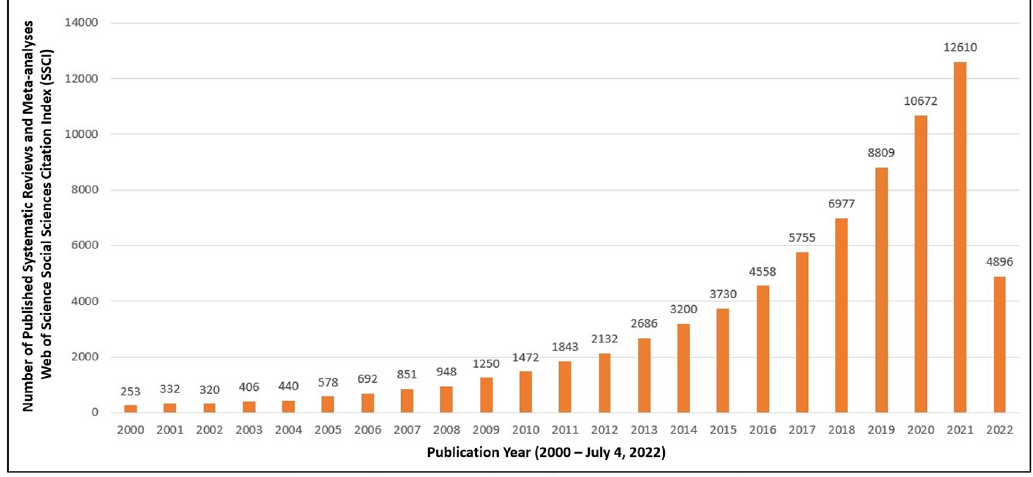
Figure 1. Social sciences systematic review and meta-analysis publications by year. Note. Figure was generated using the Web of Science Core Collection database. A title search was conducted in the Social Sciences Citation Index (SSCI) for articles and reviews published between 2000-2022 including variations of the terms “ Systematic Review ” and “ Meta-analysis ” .Search Syntax:((TI=("meta-analy*" or "metaanaly*" or metaanaly*or "system* review" or "literature review")) AND PY=(2000-2022)) AND DT=(Article OR